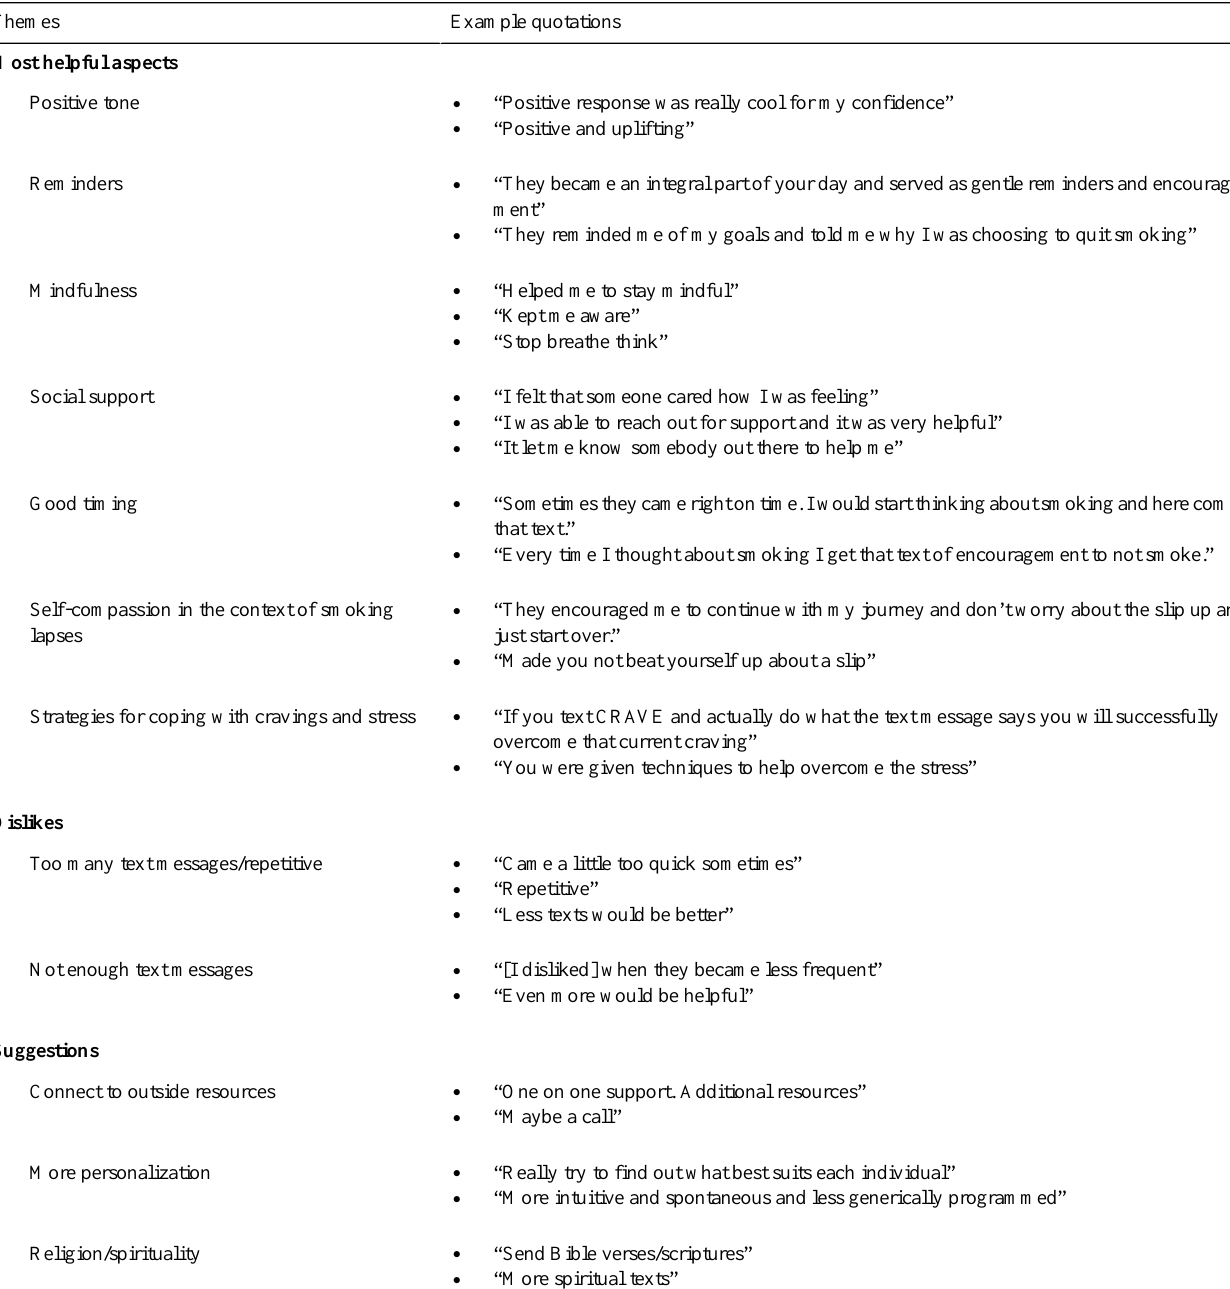
Table 2. Example quotations from open-ended iQuit Mindfully program evaluation responses. Example